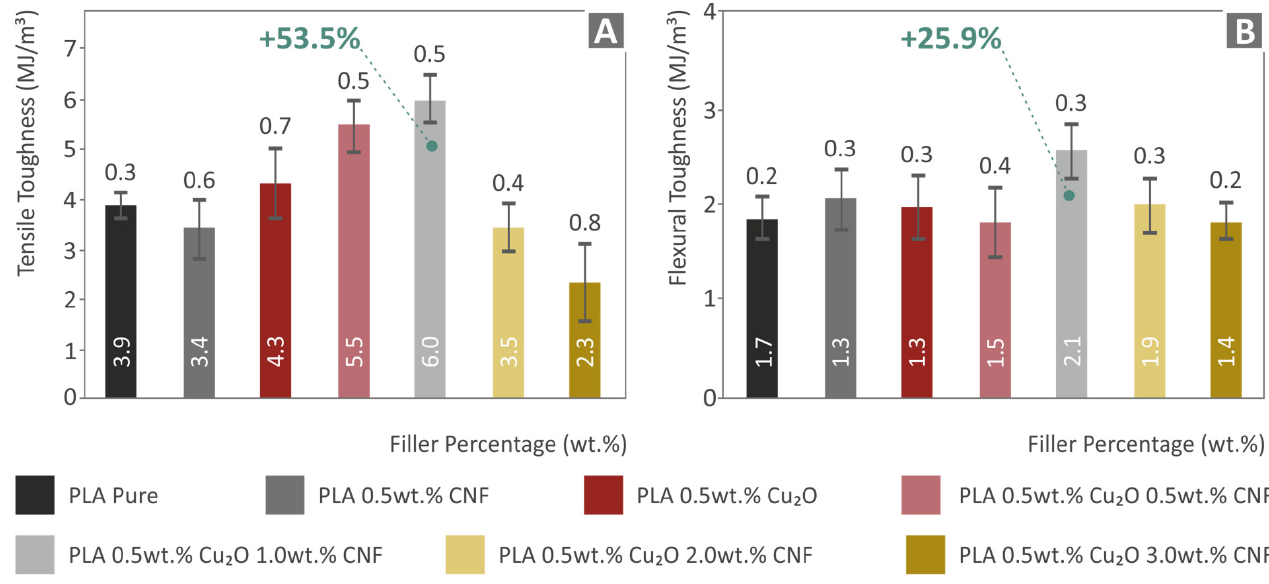
Figure 9. For all materials tested: ( A ) tensile toughness (MJ/m 3 ) and deviation (five specimens were tested), ( B ) flexural toughness (MJ/m 3 ) and deviation (five specimens were tested).